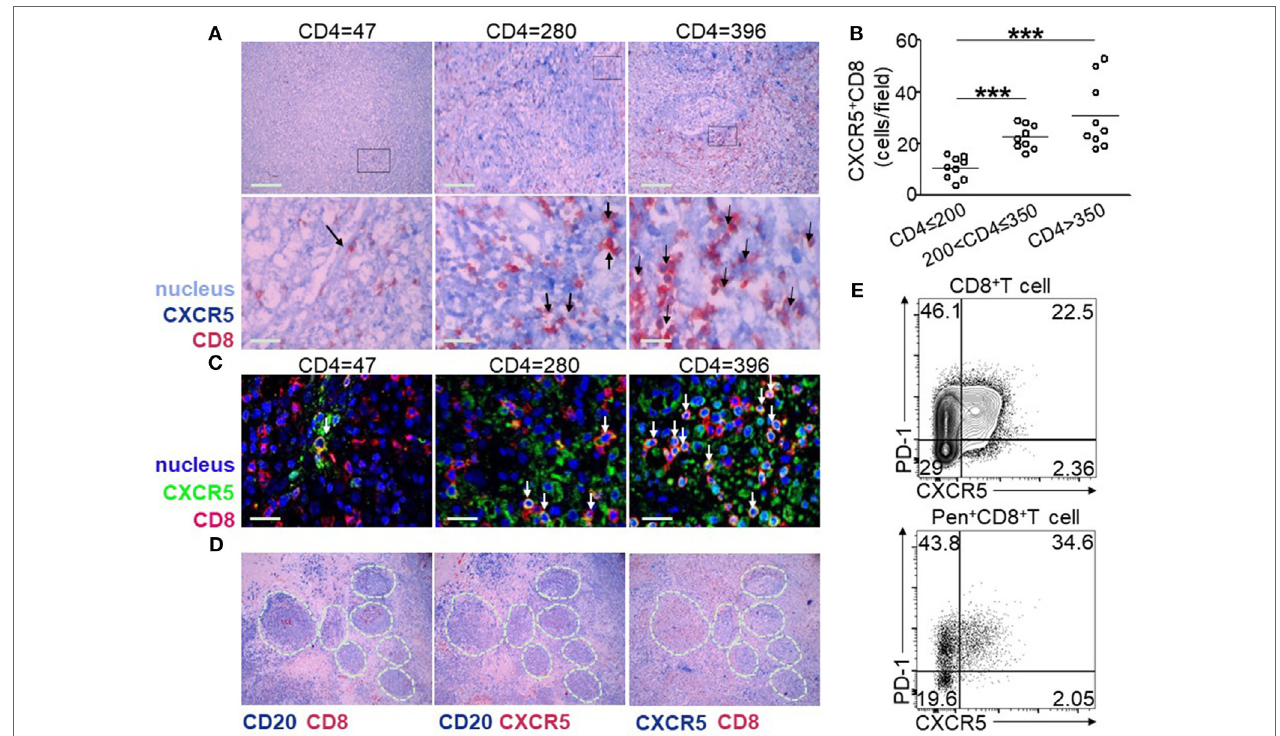
FigUre 2 | Lymph node (LN) CXCR5 + CD8 + T cells are associated with peripheral CD4 + T cell counts. (a) Representative immunohistochemical data show the tissue localization of CXCR5 + (dark blue) CD8 + (red) T cells (dark arrow) in the LNs from nine HIV-infected patients with different CD4 + T cell counts. The cell nuclei are stained light blue with hematoxylin. (B) Confocal microscopy of lymph nodes (LNs) stained with CXCR5 + (green) and CD8 + (red). The nuclei are stained using DAPI (blue). CXCR5 + CD8 + cells are double stained in yellow (white arrow). (c) Statistical analysis of CXCR5 + CD8 + T cells from three different patient groups. Each dot indicates one LN from one individual patient. The data represent three independent experiments with similar results ( n > 3 for each group, Kruskal–Wallis H non-parametric test *** p < 0.001). (D) Immunohistochemical data of the same tissue of LNs with different markers: left-CD20 (dark blue) and CD8 (red), middle- CD20 (dark blue) and CXCR5 (red), and right-CXCR5 (dark blue) and CD8 (red). CD20 + cells are used for the identification of germinal centers (GCs; white dashed lines indicate GCs). (e) Representative flow cytometric data of programmed cell death 1 (PD-1) and CXCR5 staining gated on total CD8 + T cells and Pentamer + CD8 + T cells from the cells of